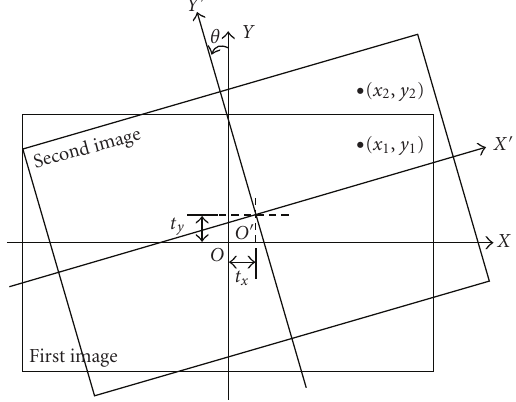
Figure 2: Rigid-body transformation (scale =